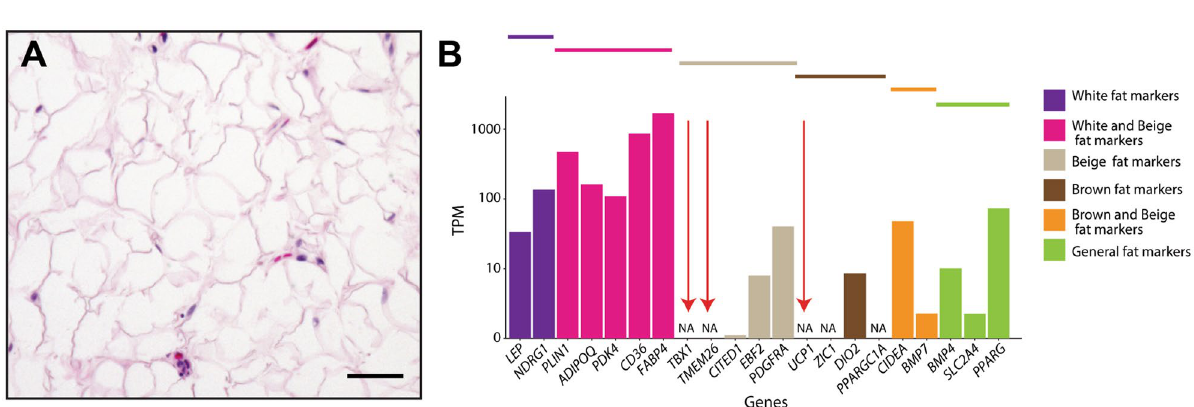
Figure 4. Mouse orbital fat resembles interscapular brown fat after thermoneutral adaptation. (A ) H&E section of interscapular brown fat (BF) from CD1 mice housed at 30 °C for 4 weeks demonstrates increased proportion of adipocytes with large lipid droplets characteristic of white adipose tissue. (B ) H&E section of orbital fat (OF) from CD1 mouse housed at 30 °C for 4 weeks demonstrates increased proportion of adipocytes with large lipid droplets characteristic of white adipose tissue. (C ) H&E section of OF from C57BL/6 mouse housed at 30 °C for 4 weeks demonstrates increased proportion of adipocytes with large lipid droplets characteristic of white adipose tissue. ( D-I ) smFISH demonstrates decreased Ucp1 expression in interscapular brown fat of mice adapted to thermoneutral temperatures (30 °C) compared to those housed near room temperature (22 °C). E Higher magnification of D. F Higher magnification of E. ( H ) Higher magnification of G. ( I ) Higher magnification of H. ( J-O ) smFISH demonstrates decreased Ucp1 expression in orbital fat of mice adapted to thermoneutral temperatures (30 °C) compared to those housed near room temperature (22 °C). ( K ) Higher magnification of J. ( L ) Higher magnification of K. ( N ) Higher magnification of M. O Higher magnification of N. ( P-U ) SmfISH demonstrates decreased Gdf5 and Cxcl12 expression in orbital fat of mice adapted to thermoneutral temperatures (30 °C) compared to those housed near room temperature (22 °C). Q Higher magnification of P. ( R ) Higher magnification of Q. ( T ) Higher magnification of S. ( U ) Higher magnification of T. Scale bars = 50 μm.